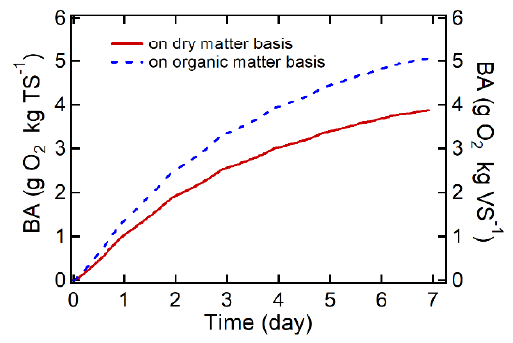
Figure 7. Cumulative oxygen consumption obtained from static respiration test of solid digestate.